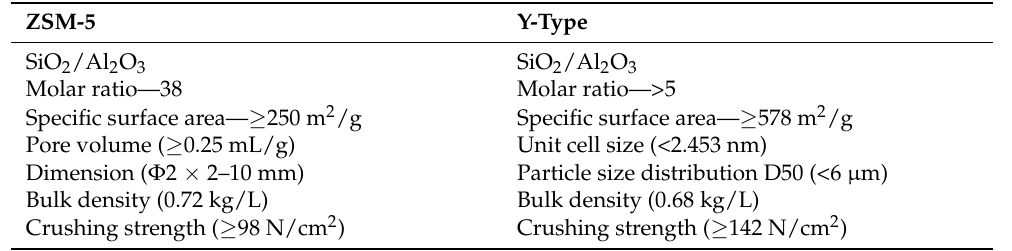
Table 1. ZSM-5 and Y-Type properties.